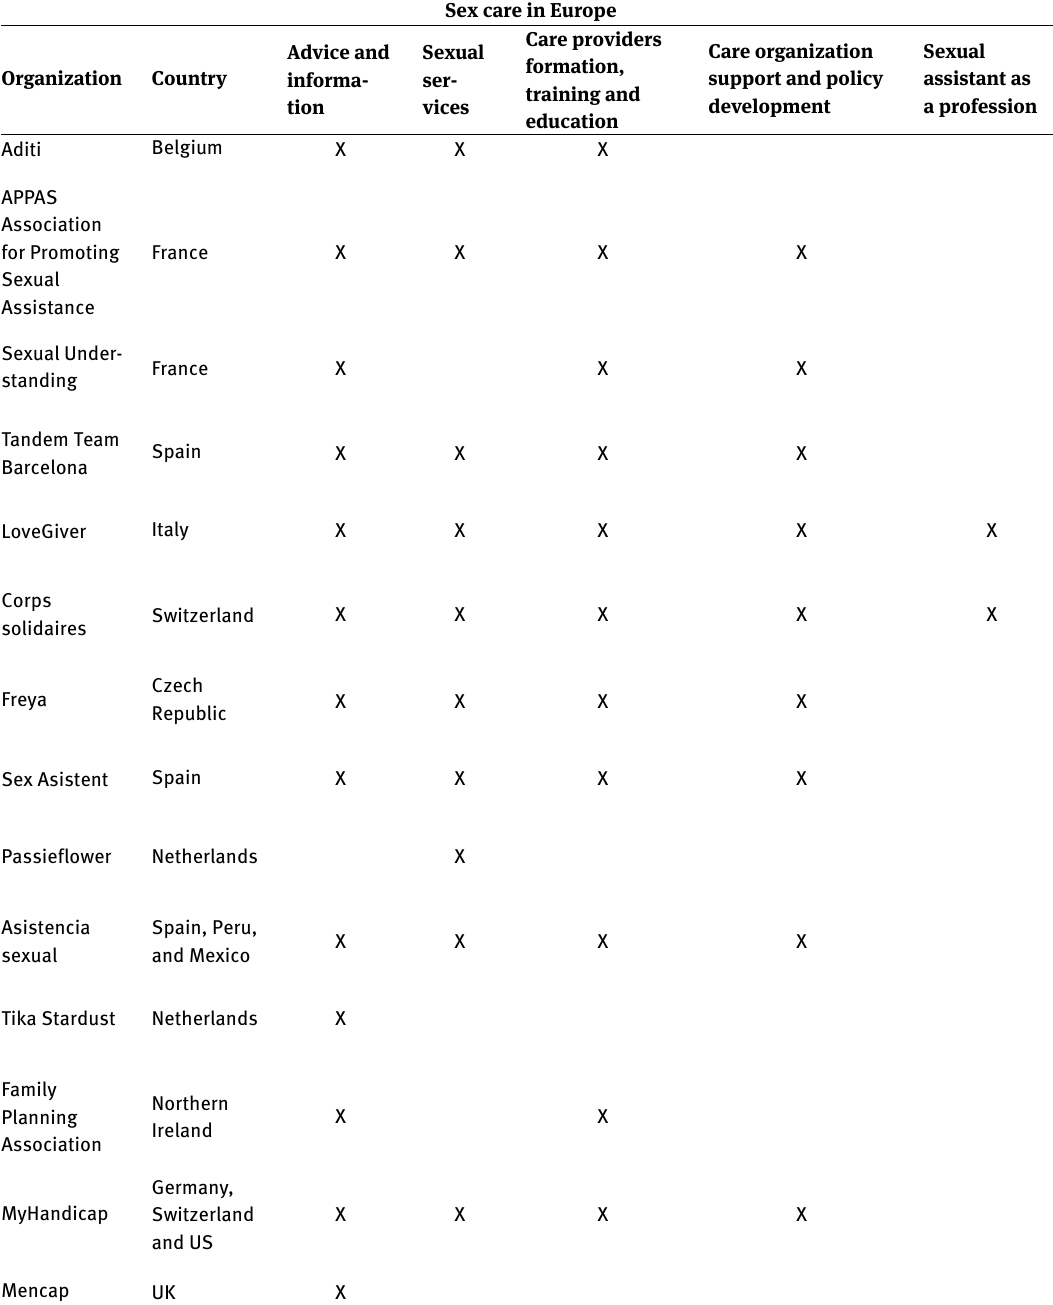
Table 1: Organisations providing different types of sex care